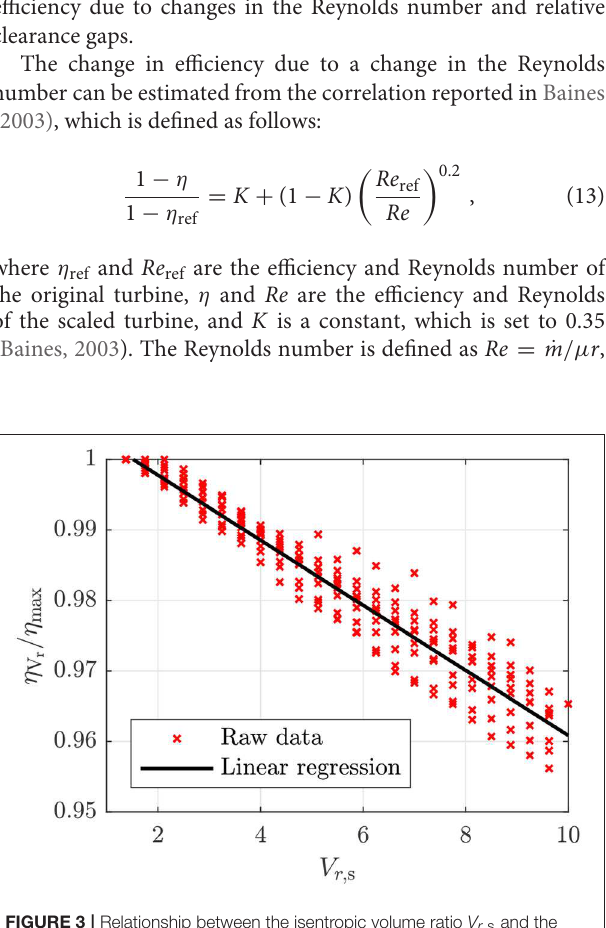
FIGURE 2 | Performance map detailing the effect of the isentropic volume ratio V r ,s and size parameter SP on the maximum isentropic total-to-static efficiency of a radial-inflow turbine (reproduced from Perdichizzi and Lozza, 1987).